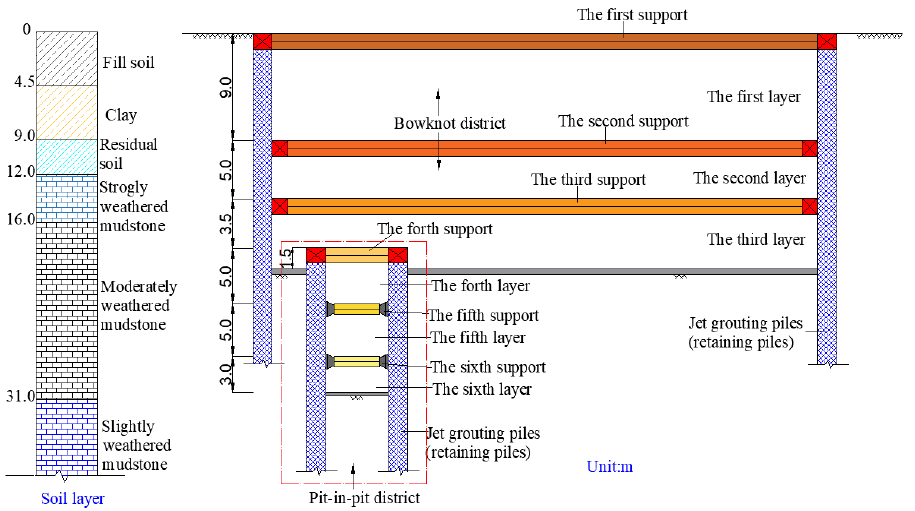
Figure 4. Supports design in the central district.